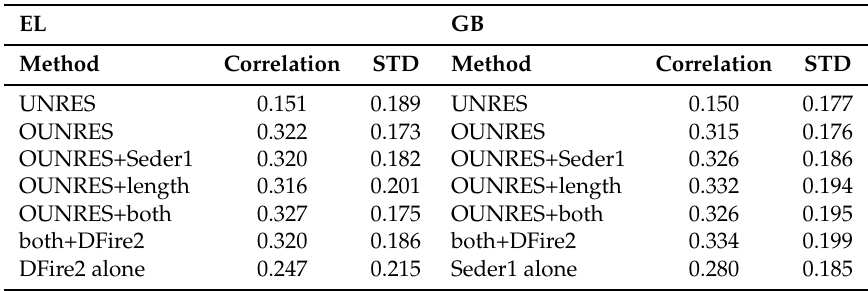
Table 5. Pearson Correlation.